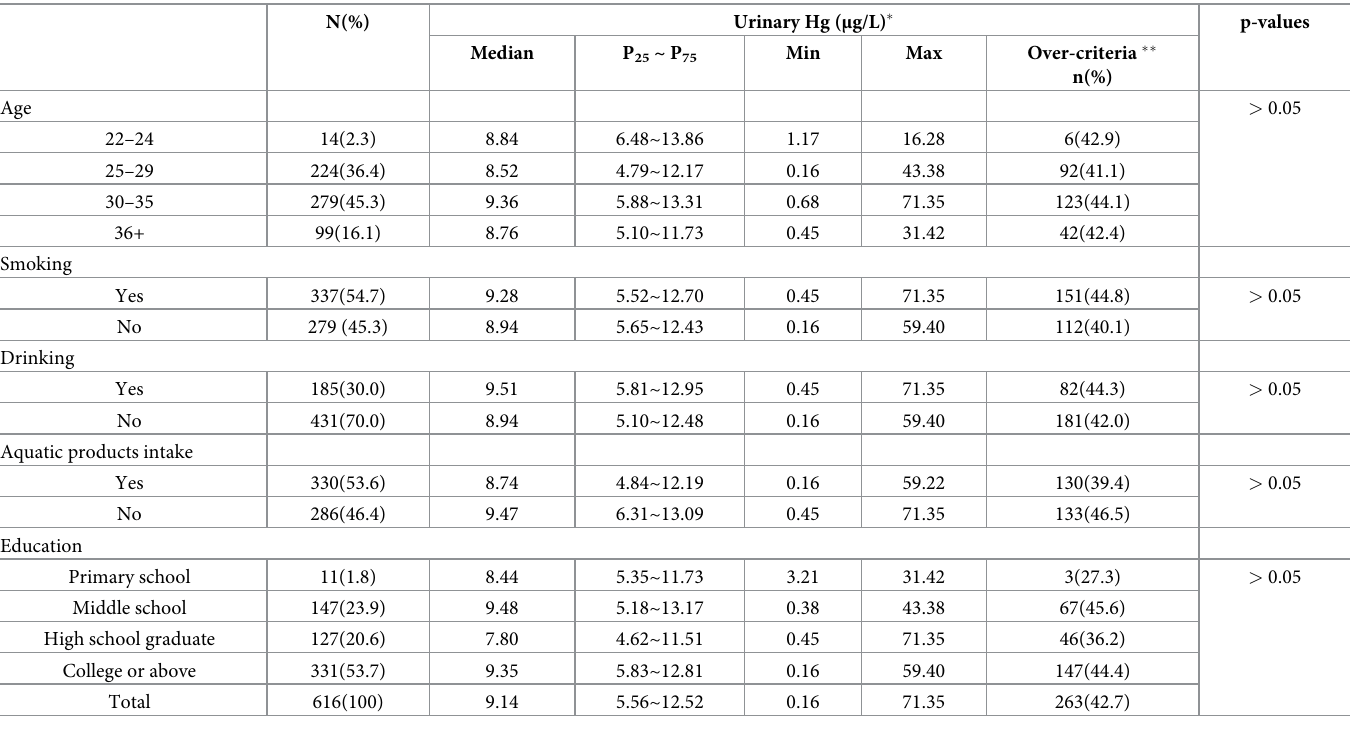
Table 2. Social-demographic characteristics and urinary Hg